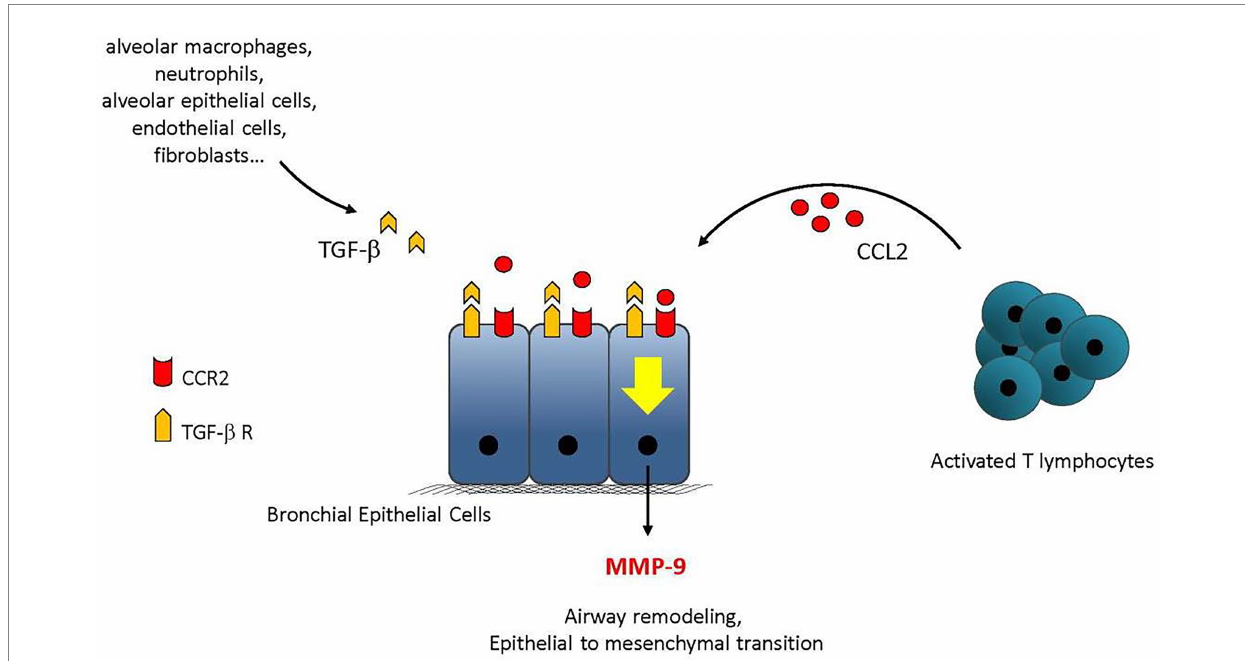
FIGURE 8 Summary of the main findings. TGF- β can be produced within the graft by alveolar macrophages, neutrophils, endothelial cells, or fibroblasts. CCL2 produced by activated T cells binds to CCR2 and supports the production of MMP-9 in synergy with TGF- β . MMP-9 then contributes to the remodeling processes leading to airway obstruction adapted from (22).